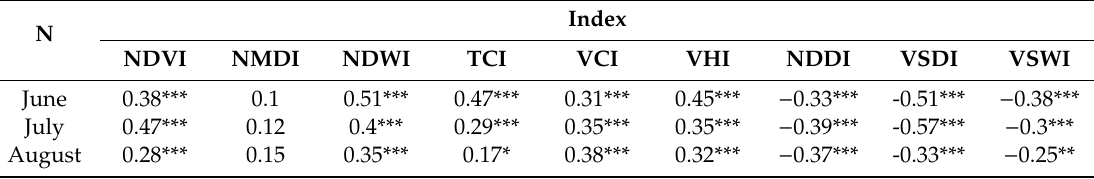
Table 4. Multi-year correlation between monthly indices and spring wheat yield in June- August (2000–2017).